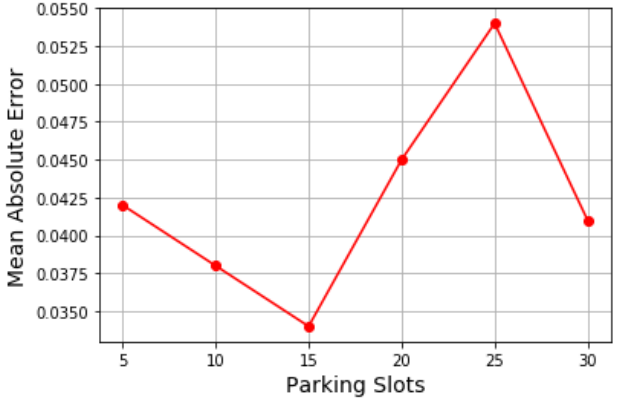
Figure 10. Performance evaluation of proposed approach by varying the parking lots count.